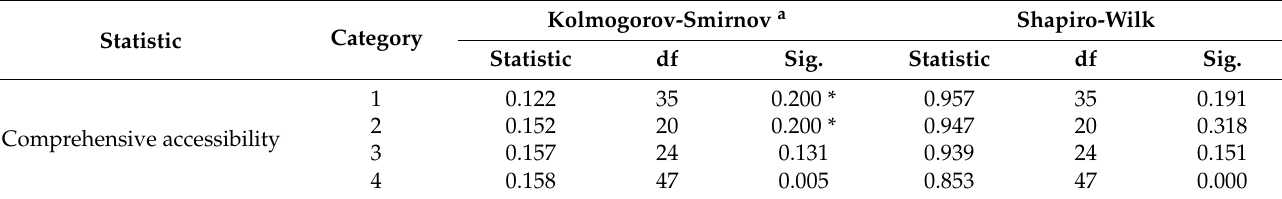
Figure 4. ( a ) Q–Q plot with the town as a factor (Changxing City), ( b ) Q–Q plot with the town as a factor (Jintang County), ( c ) Q–Q plot with the town as a factor (Qingcheng), ( d ) Q–Q plot with the town as a factor (Wu’an City). Table 6. Normality test based on the category of educational facilities.